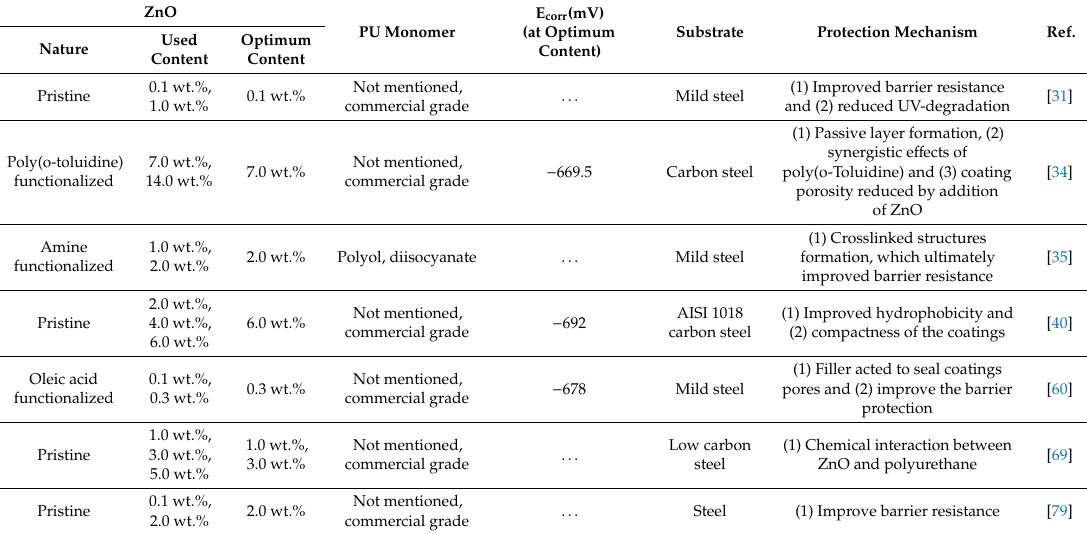
Table 7. Corrosion properties of PU / ZnO